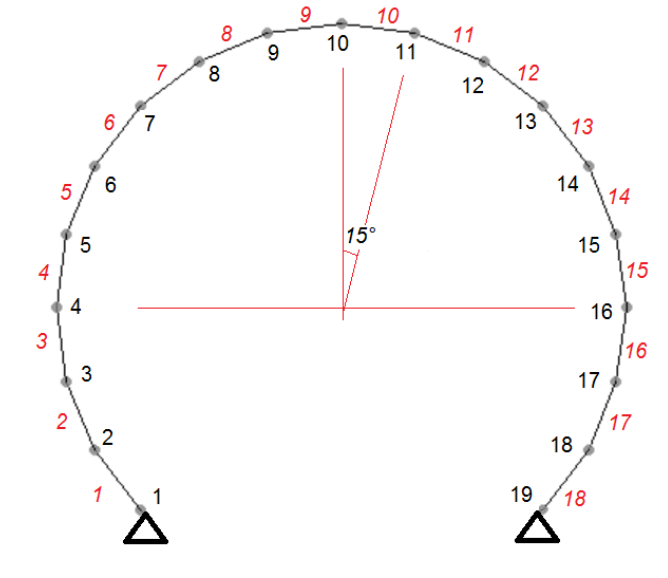
Figure 3. Model used for structural analysis in the MATLAB ® code.